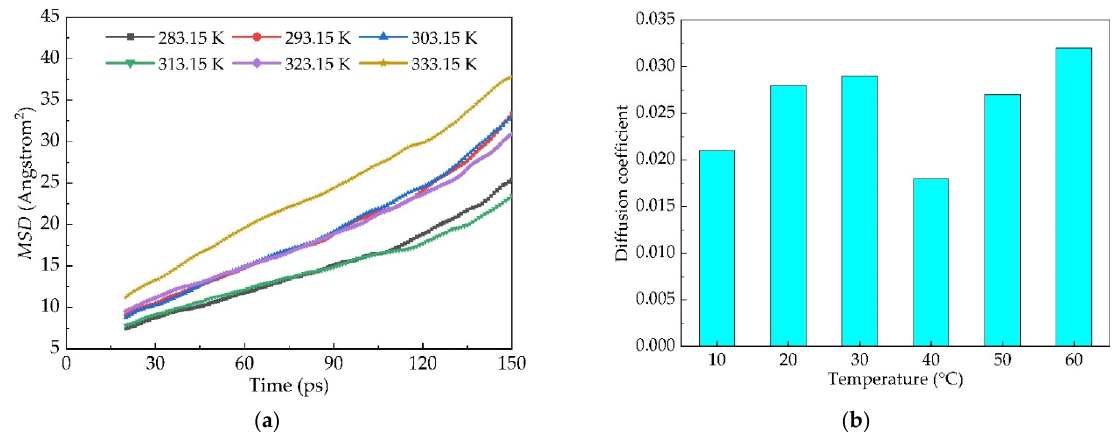
Figure 8. MSD and diffusion coefficient of Panjin 90# asphalt from old asphalt to new asphalt: ( a ) dependence of MSD as a function of time and ( b ) the dependence of diffusion coefficient as a function of temperature.